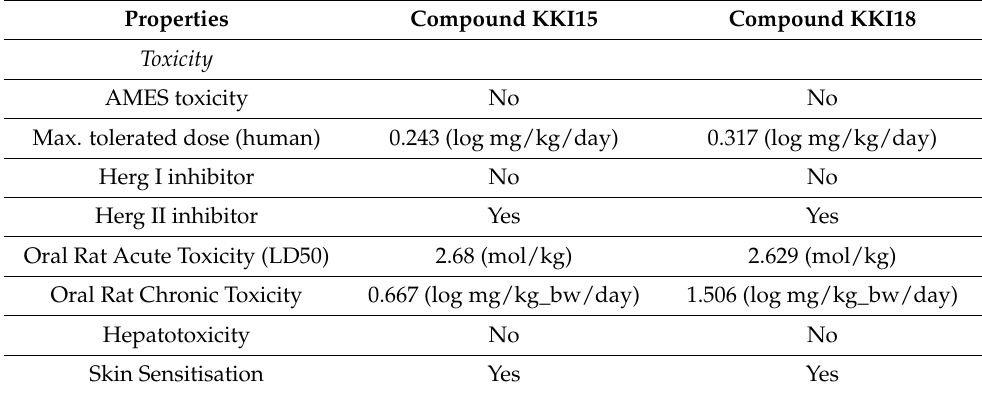
Table 11. Toxicity results of KKI15 and KKI18 according to pKCSm.